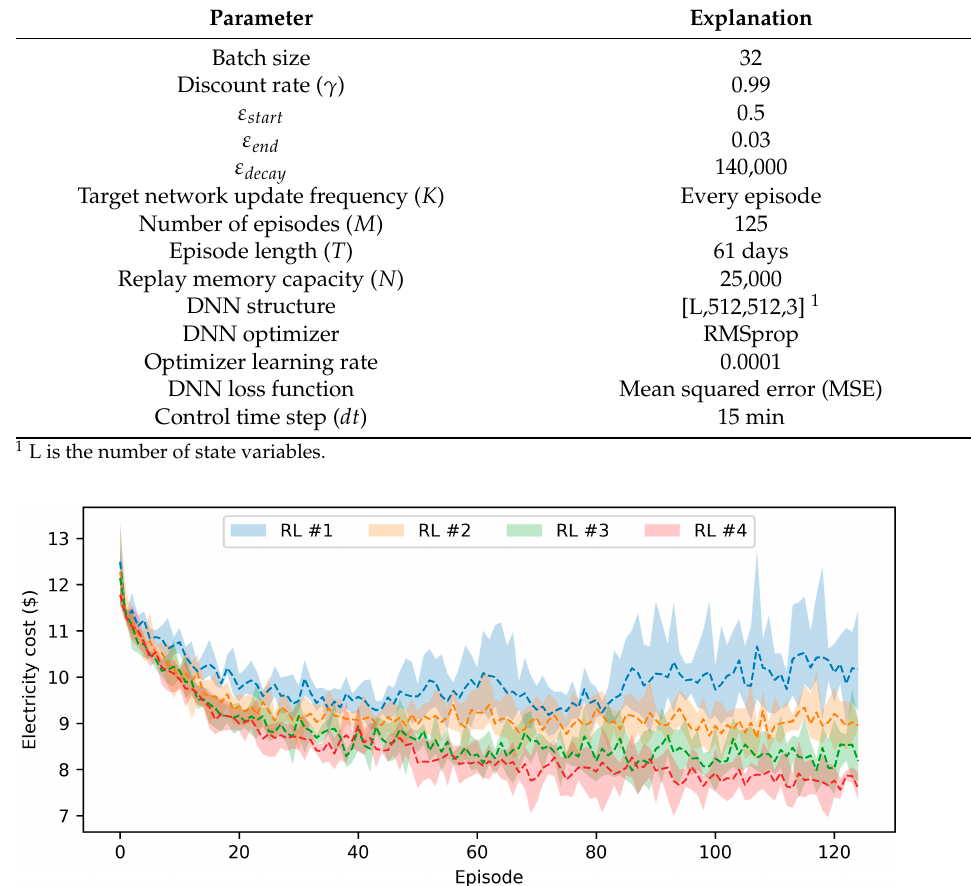
Table 4. Hyperparameters of the RL agent training.